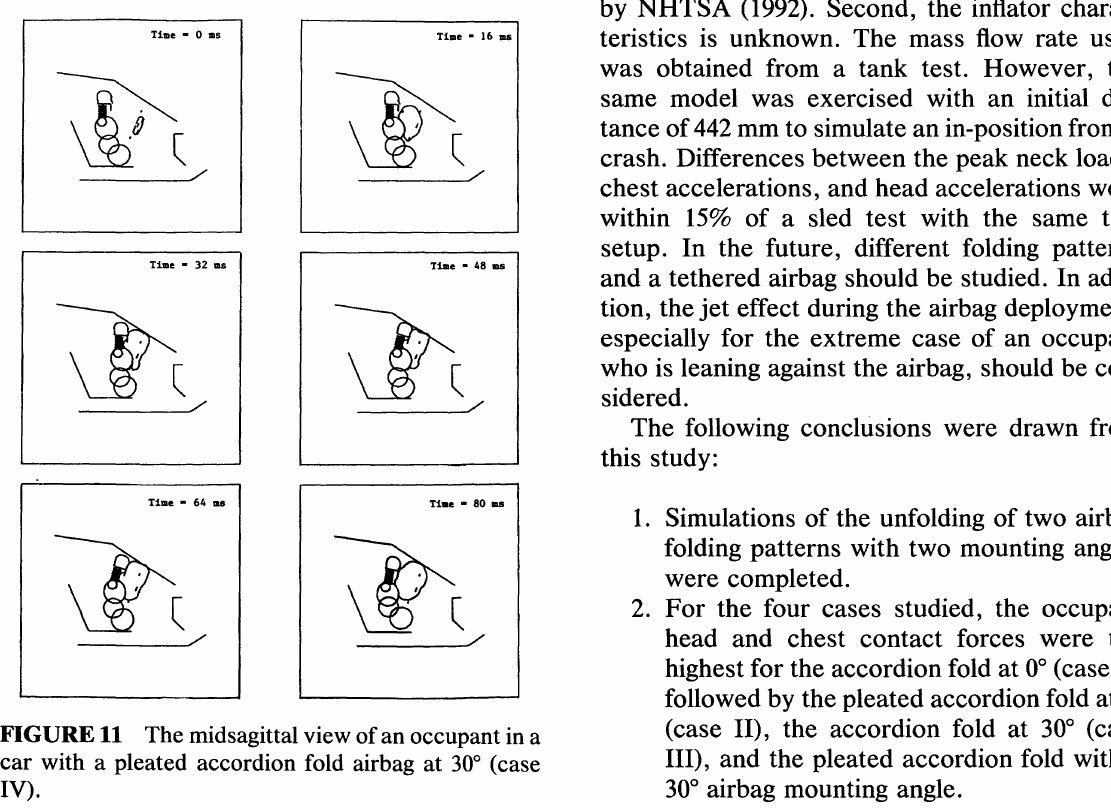
FIGURE 10 The midsagittal view of an occupant in a car with an accordion fold airbag at 30° (case III).